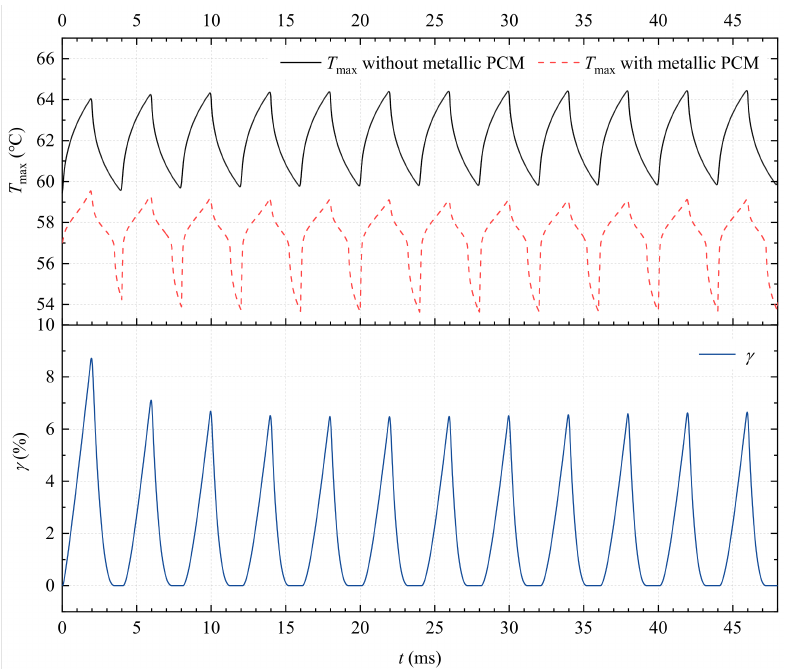
Figure 13. The variations in T max and γ with time under low peak heat flux and large duty cycle pulses heating.